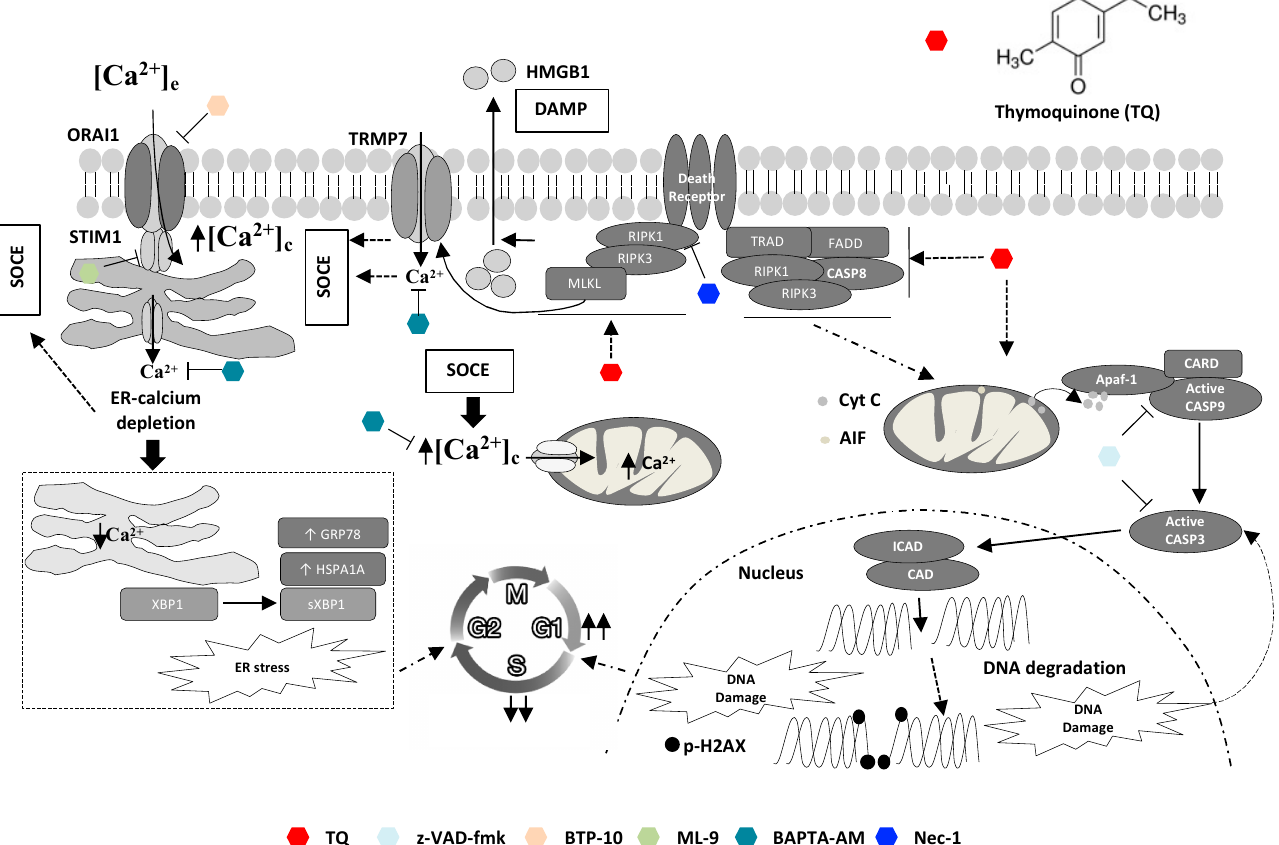
Figure 7. Graphical summary of involved mechanisms in TQ-induced cell death. TQ promotes both apoptotic and non- apoptotic cell death modalities: an early and critical role of necroptosis and cytosolic calcium. Non-apoptotic cell death involving necroptosis signaling is the most critical cell killing mechanism underlying TQ-cytotoxicity. Necroptotic features appear early after TQ treatment as evidenced by an early increase in cytosolic calcium and latterly by extracellular release of HMGB1. Both BAPTA-AM, a cytosolic calcium chelator, and nec-1, a RIPK1 inhibitor, reversed TQ-induced non-apoptotic cell death. Cytosolic calcium increase during TQ treatment involves activation of SOCE after ER-calcium depletion, which also leads to ER stress as manifested by increase of GRP78, HSPA1A, and sXBP1; BTP-10 and ML-9, inhibitors of STIM1 and ORAI, respectively, blocked SOCE. Promotion of SOCE occurs more likely downstream to necroptosis initiation and is potentially mediated by TRMP7; nec-1 reduced TQ-induced SOCE. Apoptotic effect of TQ occurs through the intrinsic pathway as highlighted by cytochrome c release from the mitochondria and caspase-9/3 activations leading to PARP cleavage and potentially to DNA damage after DNA fragmentation by ICAD activated in turn by active caspase-3. The pan-caspase inhibitor z-VAD-fmk blocked caspase activity, but failed to reverse the cell death in most cells except the less sensitive cells. DNA damage and ER stress and their upstream inducers cooperate to TQ-induced cell cycle arrest.